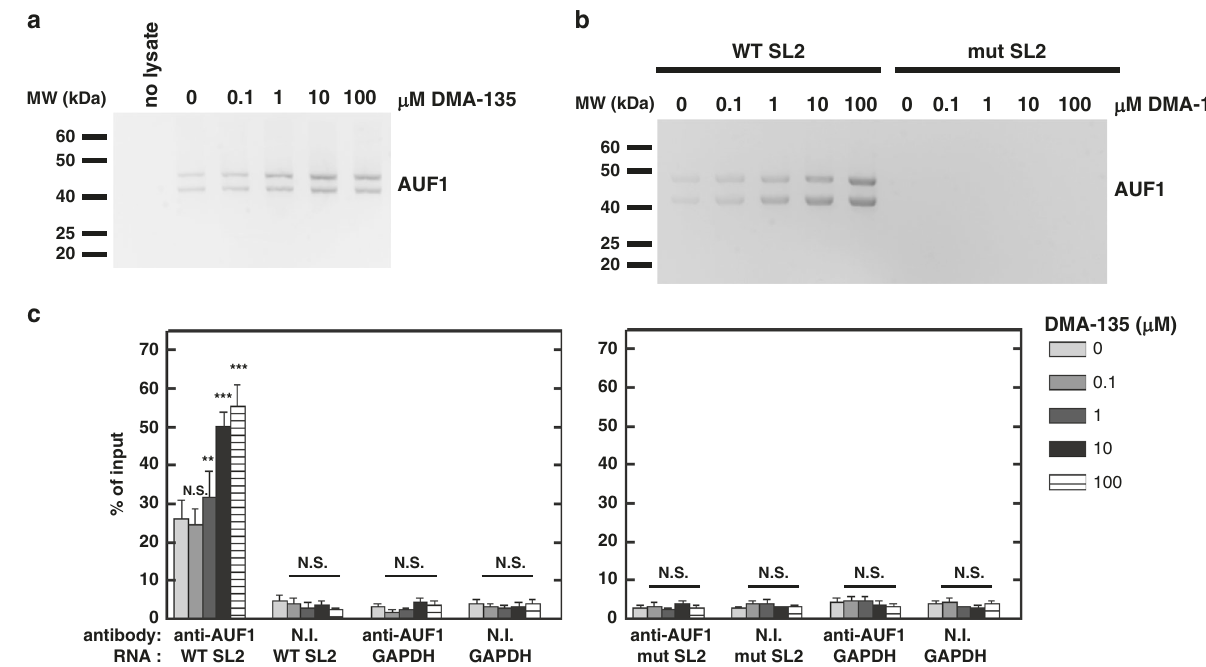
Fig. 7 Allosteric effects of DMA-135 within the cellular environment. a Protein-biotinylated RNA pull-down experiments were performed to examine the effect of DMA-135 on the interaction between AUF1 and the EV71 SLII IRES domain. Biotinylated SLII was incubated with SF268 cell lysate to which was added the indicated concentrations of DMA-135. Streptavidin-linked beads were used to pull-down biotin-labeled SLII and its associated cellular proteins. Samples were analyzed by western blot using anti-AUF1 antibody. The experiment was performed twice yielding similar results. b Biotinylated wild-type SLII or the CCC-bulge mutant SLII were transfected into SF268 cells. Cells were cultured with various concentrations of DMA-135. Cell lysates were used for pull-down assays of SLII-associated proteins as described above. AUF1 bound to SLII RNA was detected by western blotting. The experiment was performed twice yielding similar results. c RIP assays for AUF1-EV71 Luc RNA interactions in cells. SF268 cells were transfected with RLuc-EV71 5 ′ UTR- FLuc RNA, harboring the wild-type SLII, or with CCC-bulge mutant SLII and cultured with various concentrations of DMA-135. Lysates were prepared and analyzed by ribonucleoprotein immunoprecipitation (RIP) with non-immune (NI) antibody or AUF1 antibody. Both input and immunoprecipitated materials were analyzed by qRT-PCR for EV71 RNA. NI, non-immune antibody. Mean values±standard deviations from three independent experiments ( N = 3) are shown. P values were determined by unpaired two-tailed Student ’ s t test. *** P < 0.001; ** P < 0.01; N.S., not signi fi